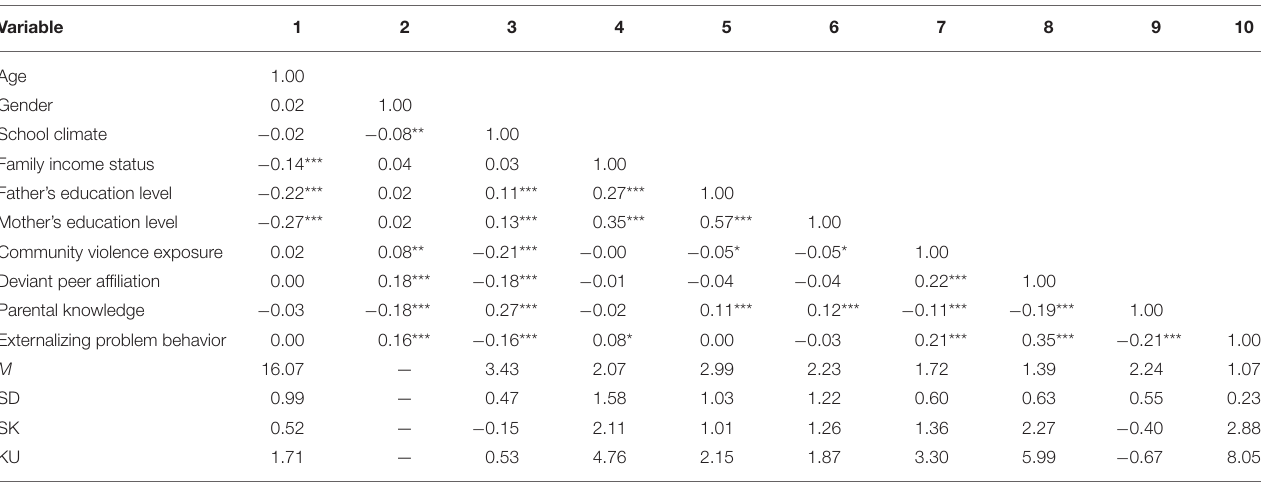
TABLE 1 | The Pearson product-moment correlations for all variables. Variable